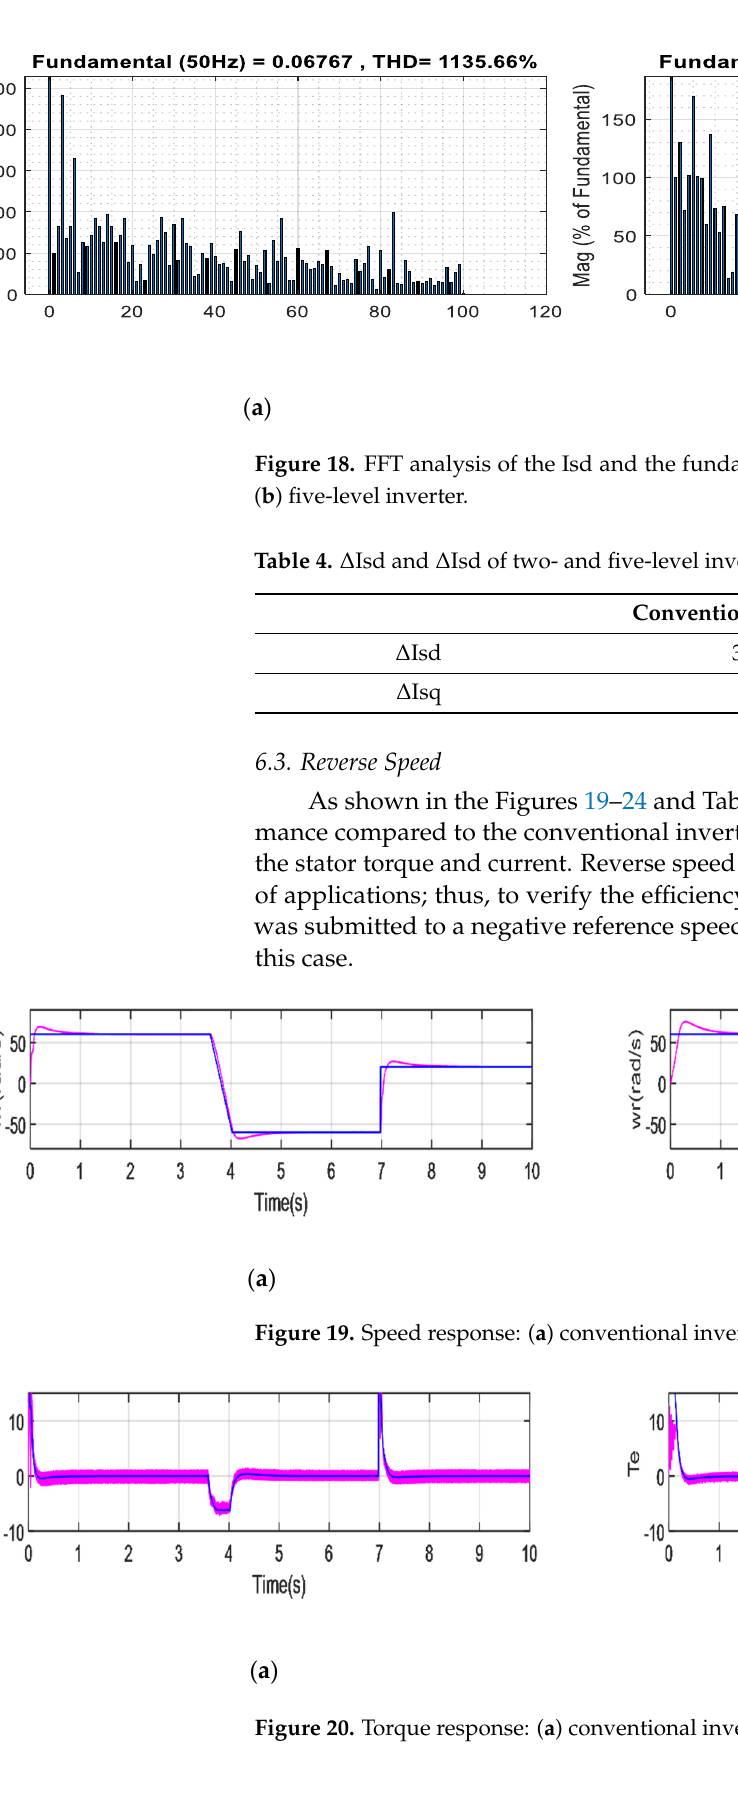
( b ) Figure 21. Stator current: ( a ) conventional inverter; ( b ) five-level inverter. ( a ) ( b ) Figure 22. Isq components: ( a ) conventional inverter; ( b ) five-level inverter. ( a ) ( b ) Figure 23. Isd components: ( a ) conventional inverter; ( b ) five-level inverter.